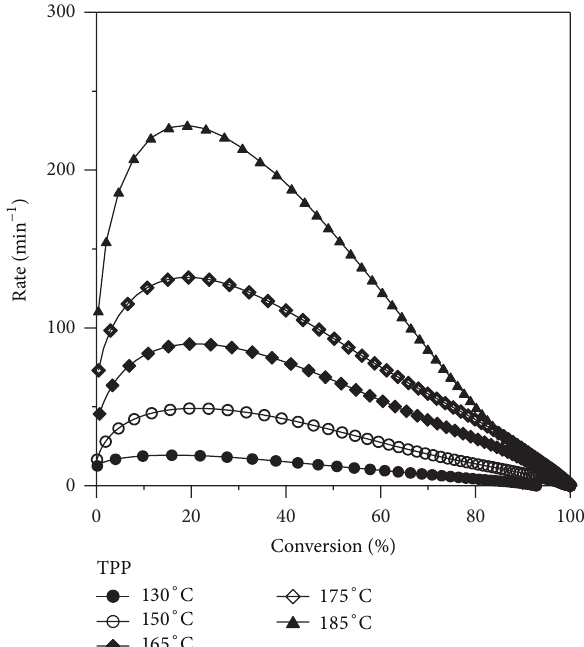
Figure 8: Plots of the reaction rate versus conversion for TPP-cured EMCs at isothermal temperatures.